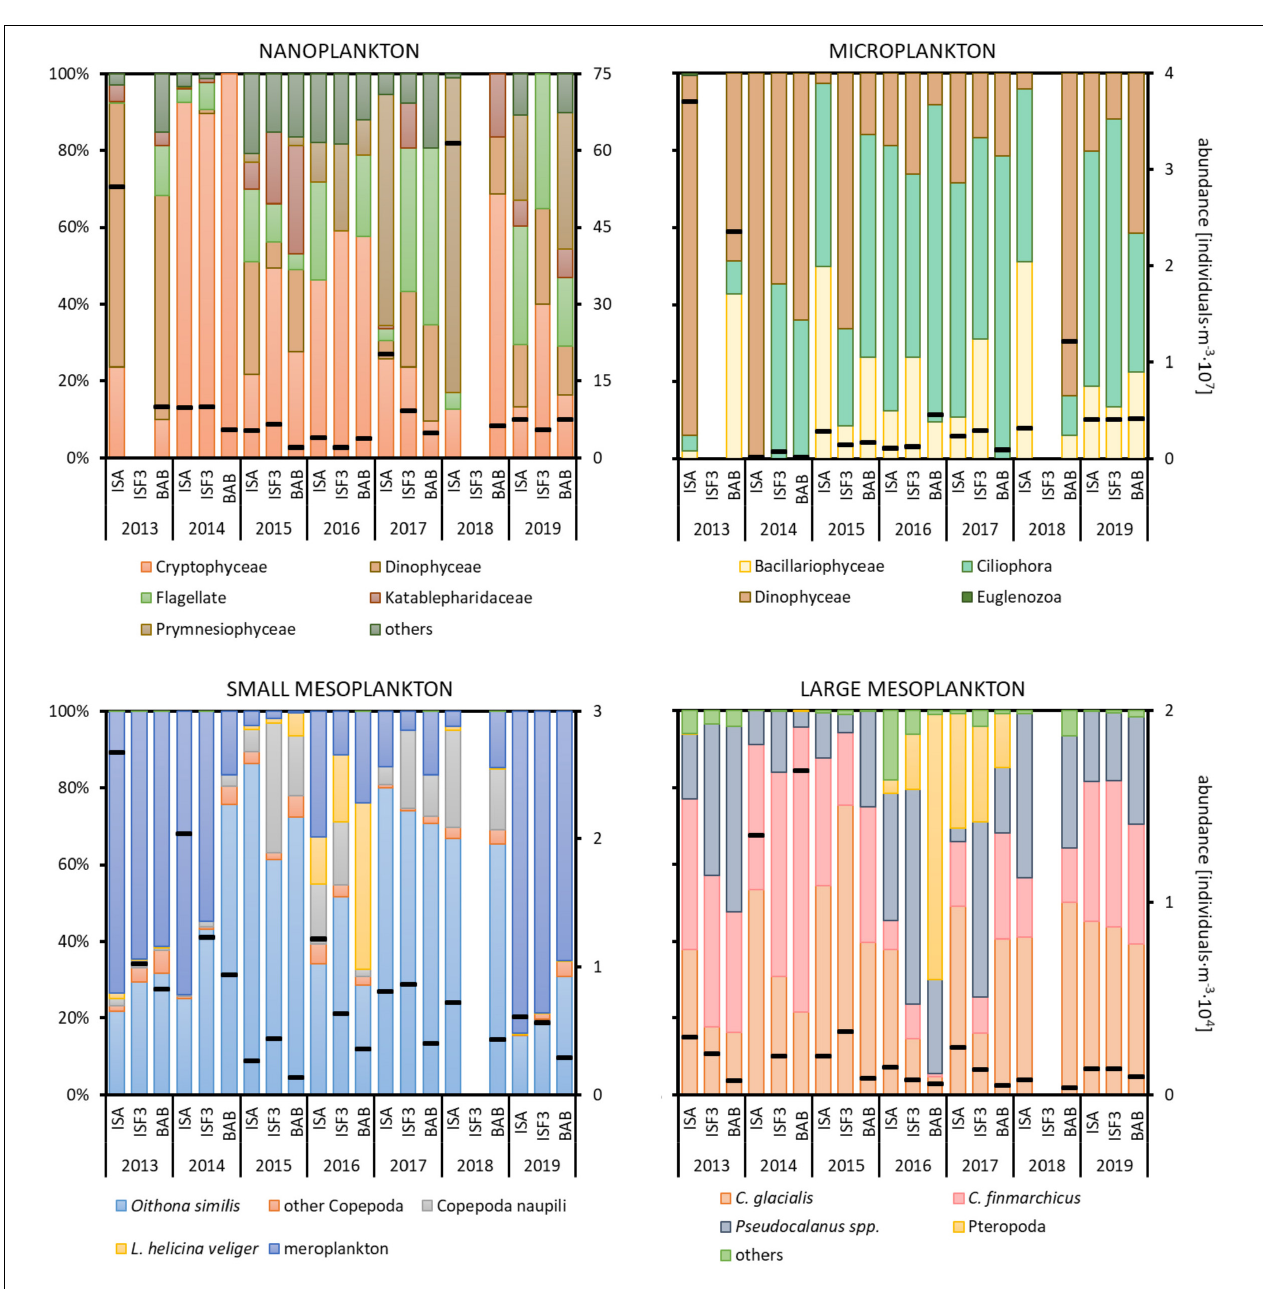
FIGURE 4 | Abundance (black dashes) of various plankton size fractions (individuals · m − 3 ) and relative abundances (%) of the major taxonomic groups at three Isfjorden stations: ISA, ISF3 and BAB in seven consecutive mid-summers (2013–2019). Data for protists at ISF3 station were not collected in 2013 and 2018, whereas for zooplankton in 2018. Note different scales for size